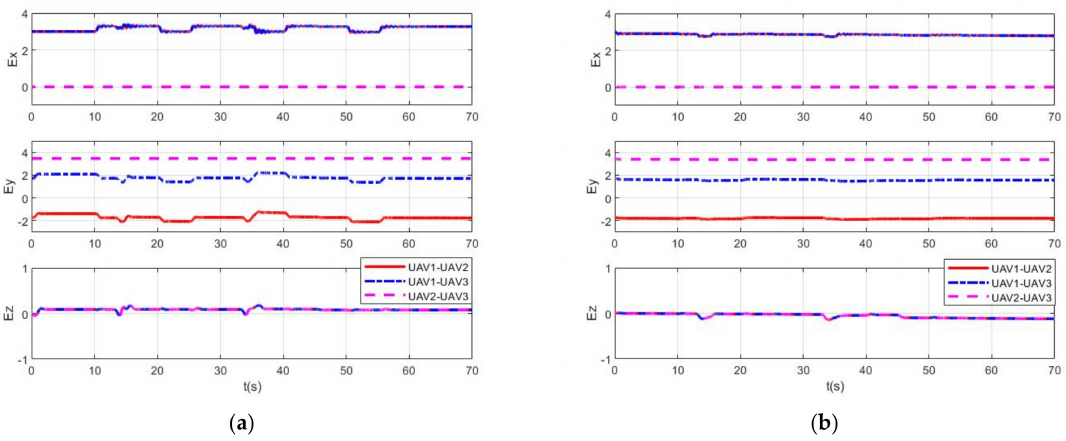
Figure 15. Distance between UAVs with RMPC ( a ) and IMPC ( b ) in the direction of three axes in Case 2. The formation with IMPC has less variation in distance between the quadrotors, not only in normal flight but also in response to turning and impulse.